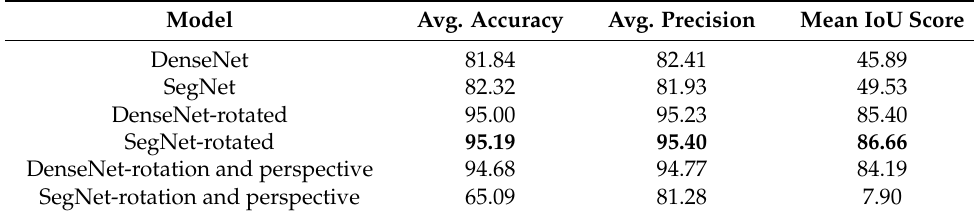
Table 3. Model architecture comparison on specific tooth